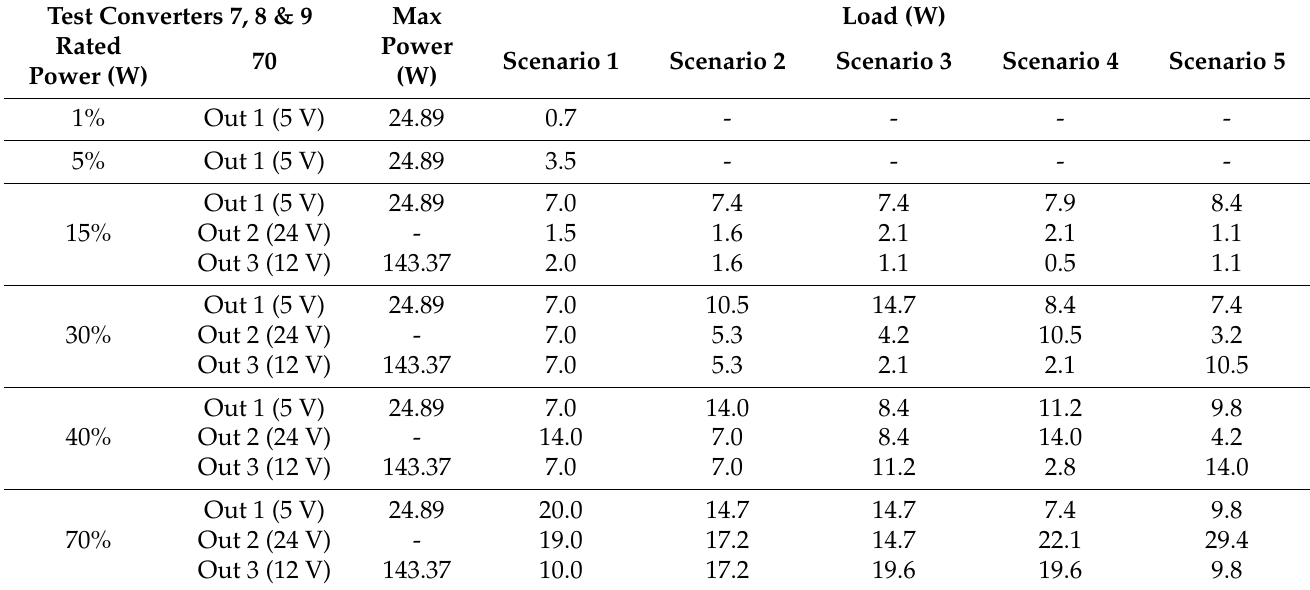
Table 5. Test plan for 70 W multi-output converters.